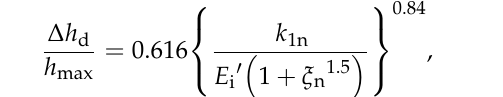
Figure 4. Degree of elastic deformation of conical indenter Δ h d / h max estimated with Equation (6) plotted against Δ h d / h max evaluated with Equation (3’).